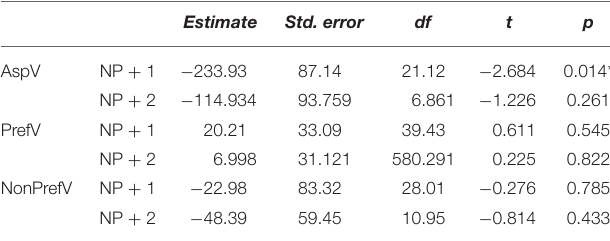
TABLE 6 | Reading time results affected by NP predictability with the data subset by verb type.